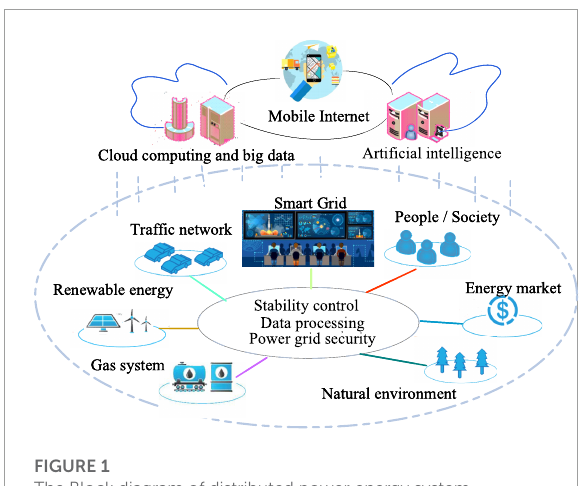
FIGURE 1 The Block diagram of distributed power energy